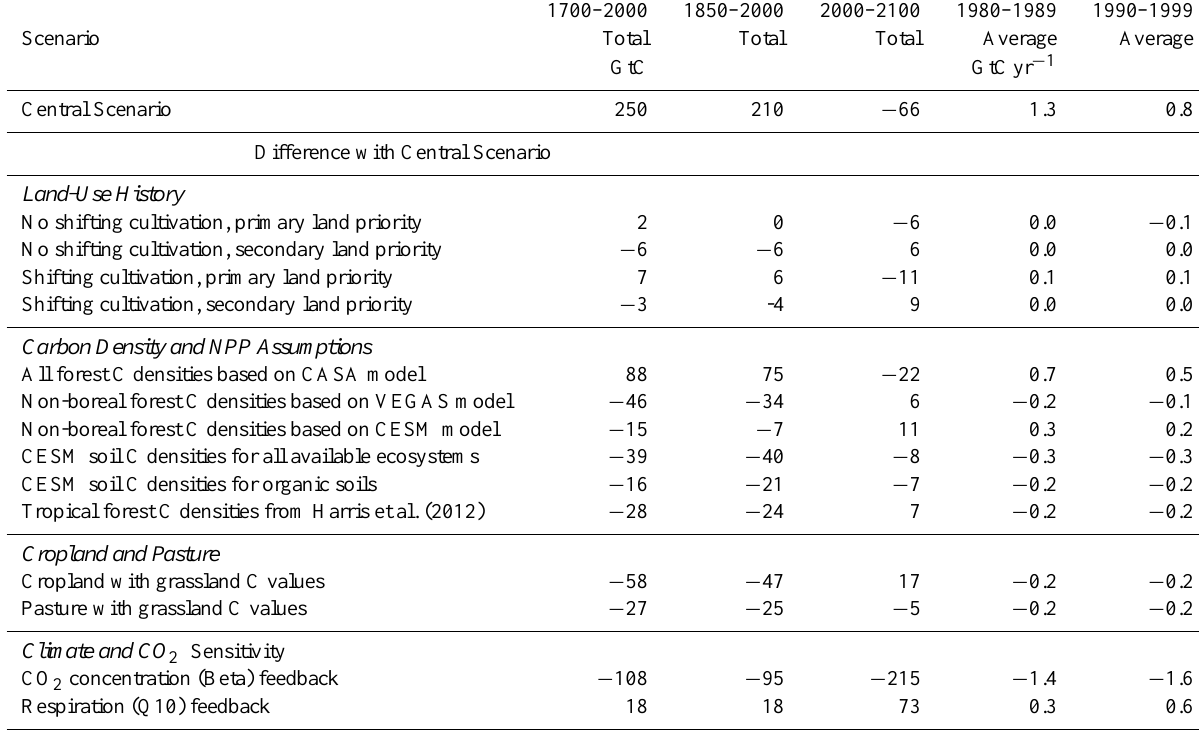
Table 6. Global land-use change emissions from sensitivity